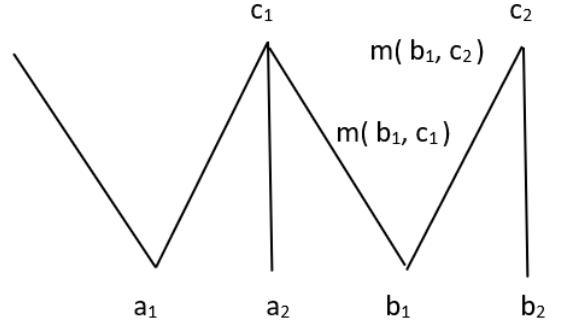
Figure 2. Complex Hierarchy: CH C.